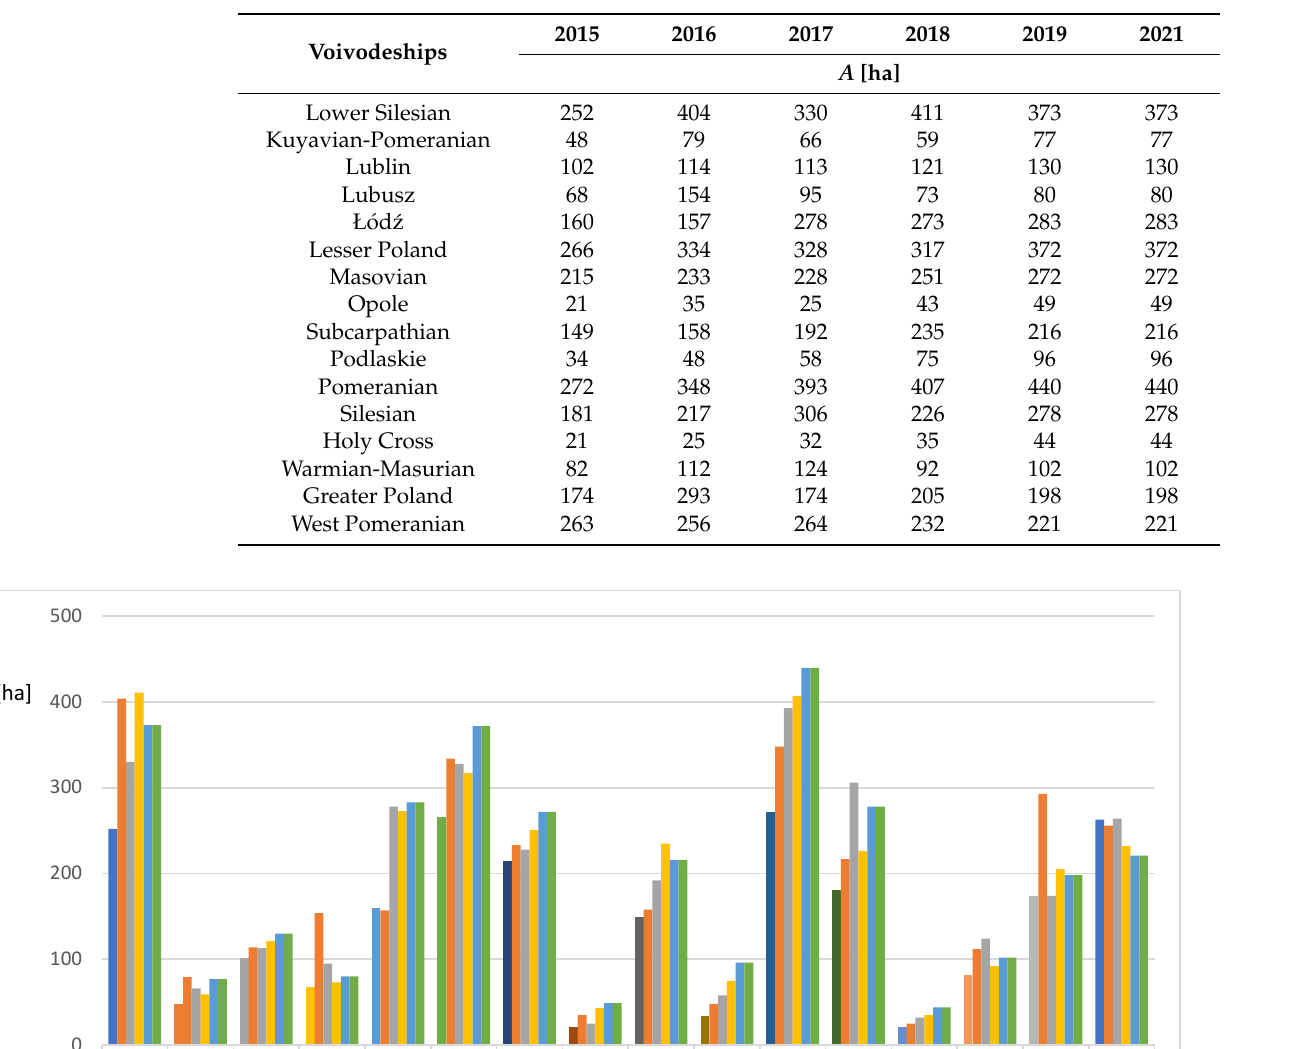
Table 19. Area of agricultural land potentially useful for the cultivation of energy crops [146].